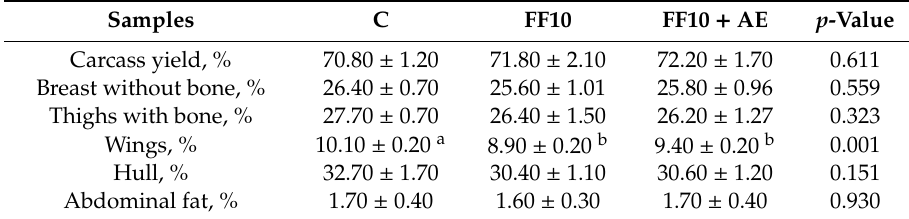
Table 5. The results of the carcass yield of broilers (means ± SD).